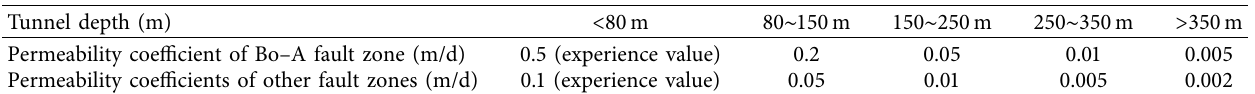
Table 4: Permeability coefficient values of the tunnel passing through the fault zone and the surrounding rock in the affected zone. Tunnel depth (m)